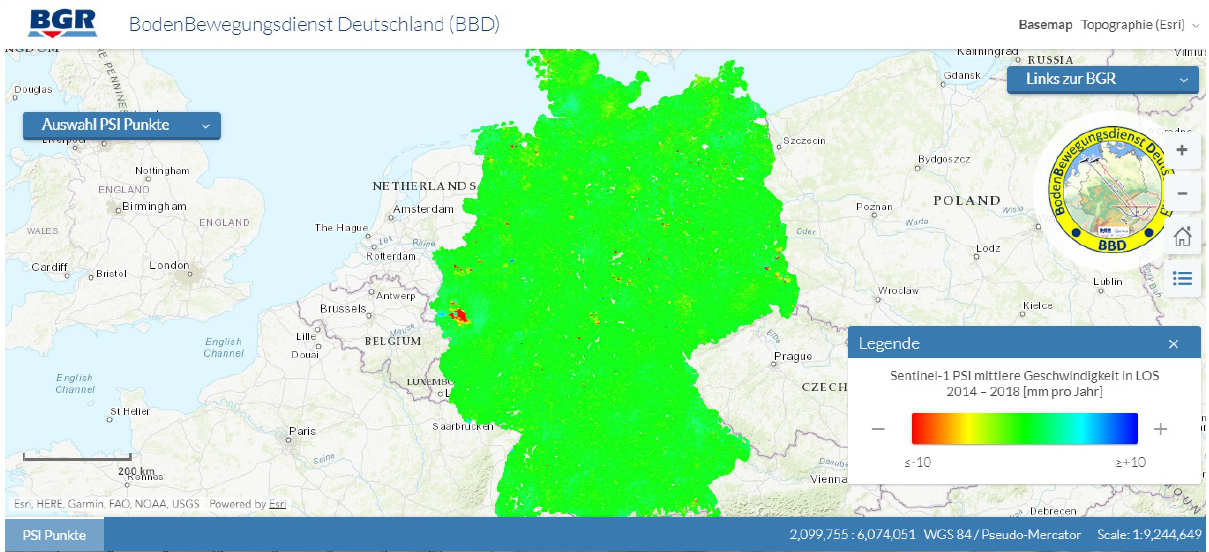
Figure 3: View of the geoportal of the BodenBewegungsdienst Deutschland. https://bodenbewegungsdienst.bgr.de.